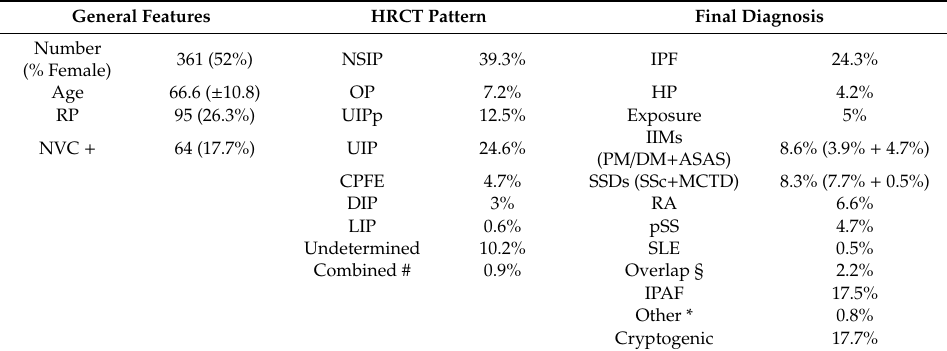
Table 1. Characteristics of the interstitial lung disease (ILD) cohort